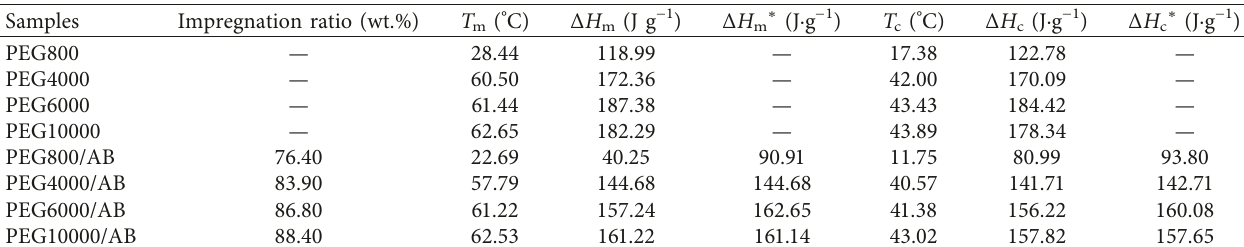
Table 2: Thermal analysis of the PEG/AB composites and pure PEGs with varying molecular weights. Samples